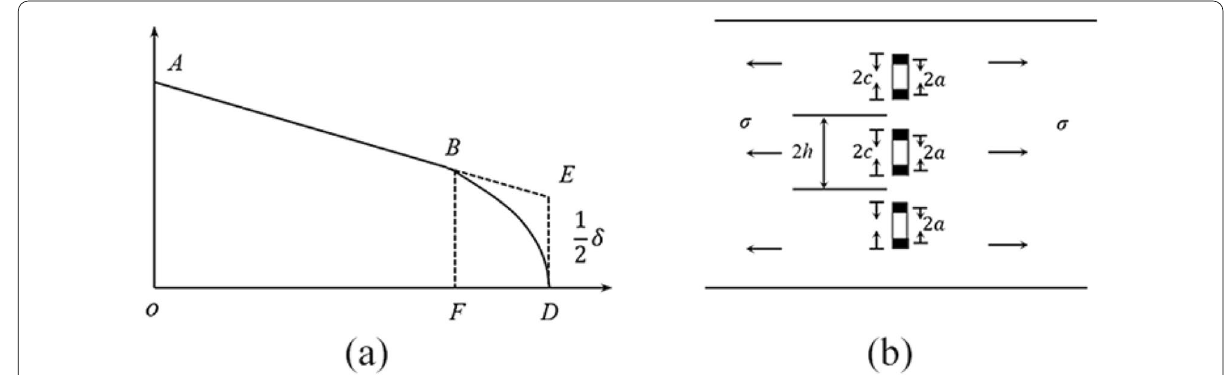
Figure 1 Cracking mechanism of Ni-based coating [37]: ( a ) critical opening displacement, ( b ) microcracks of